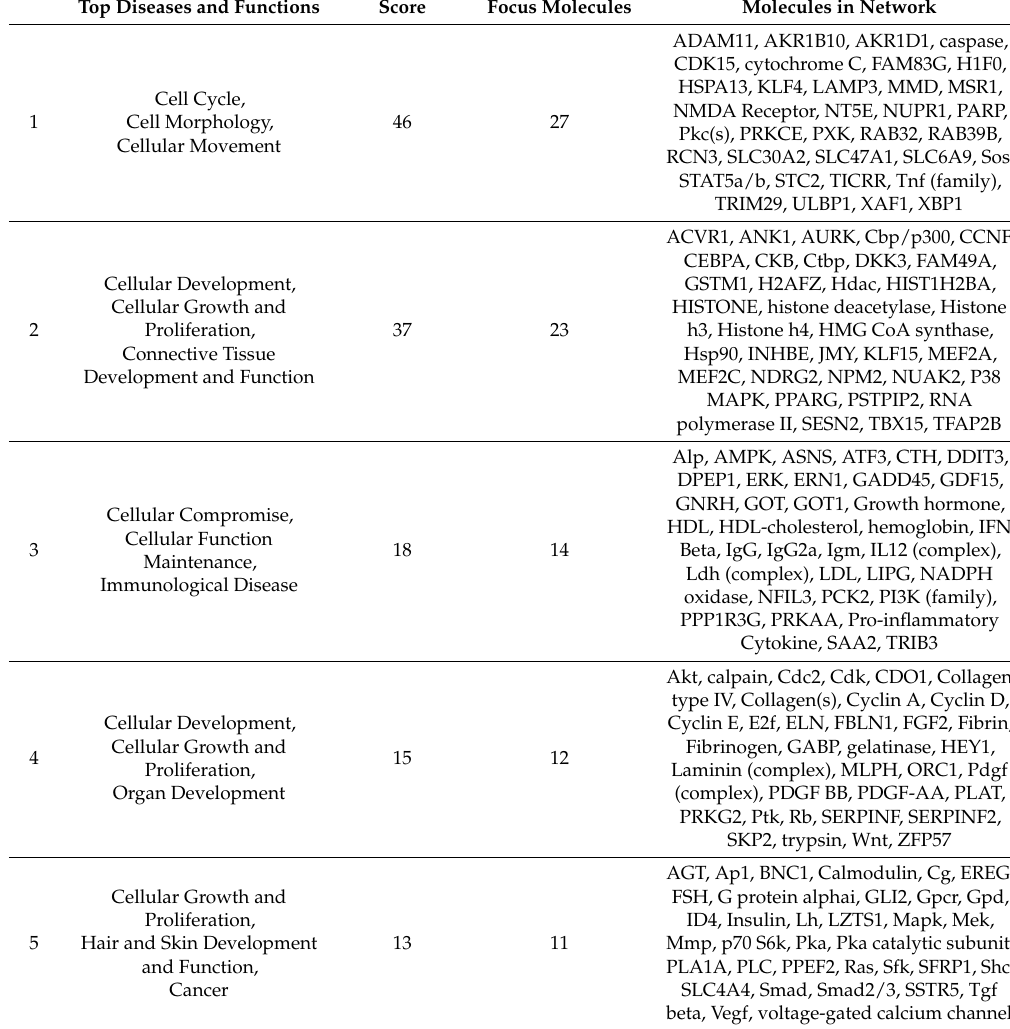
Table 2. The networks associated with genes differentially expressed in diabetic PTECs in IPA database. Top Diseases and Functions Score Focus Molecules Molecules in